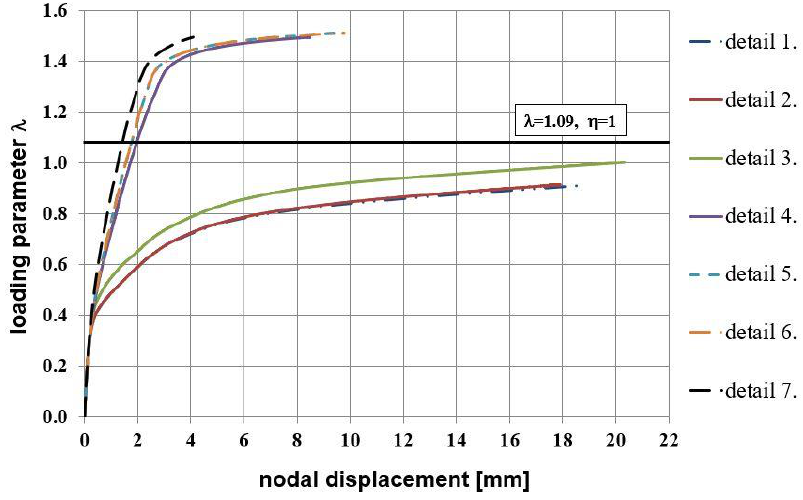
Figure 21. Nodal displacement vs. loading parameter in the plane stress state.